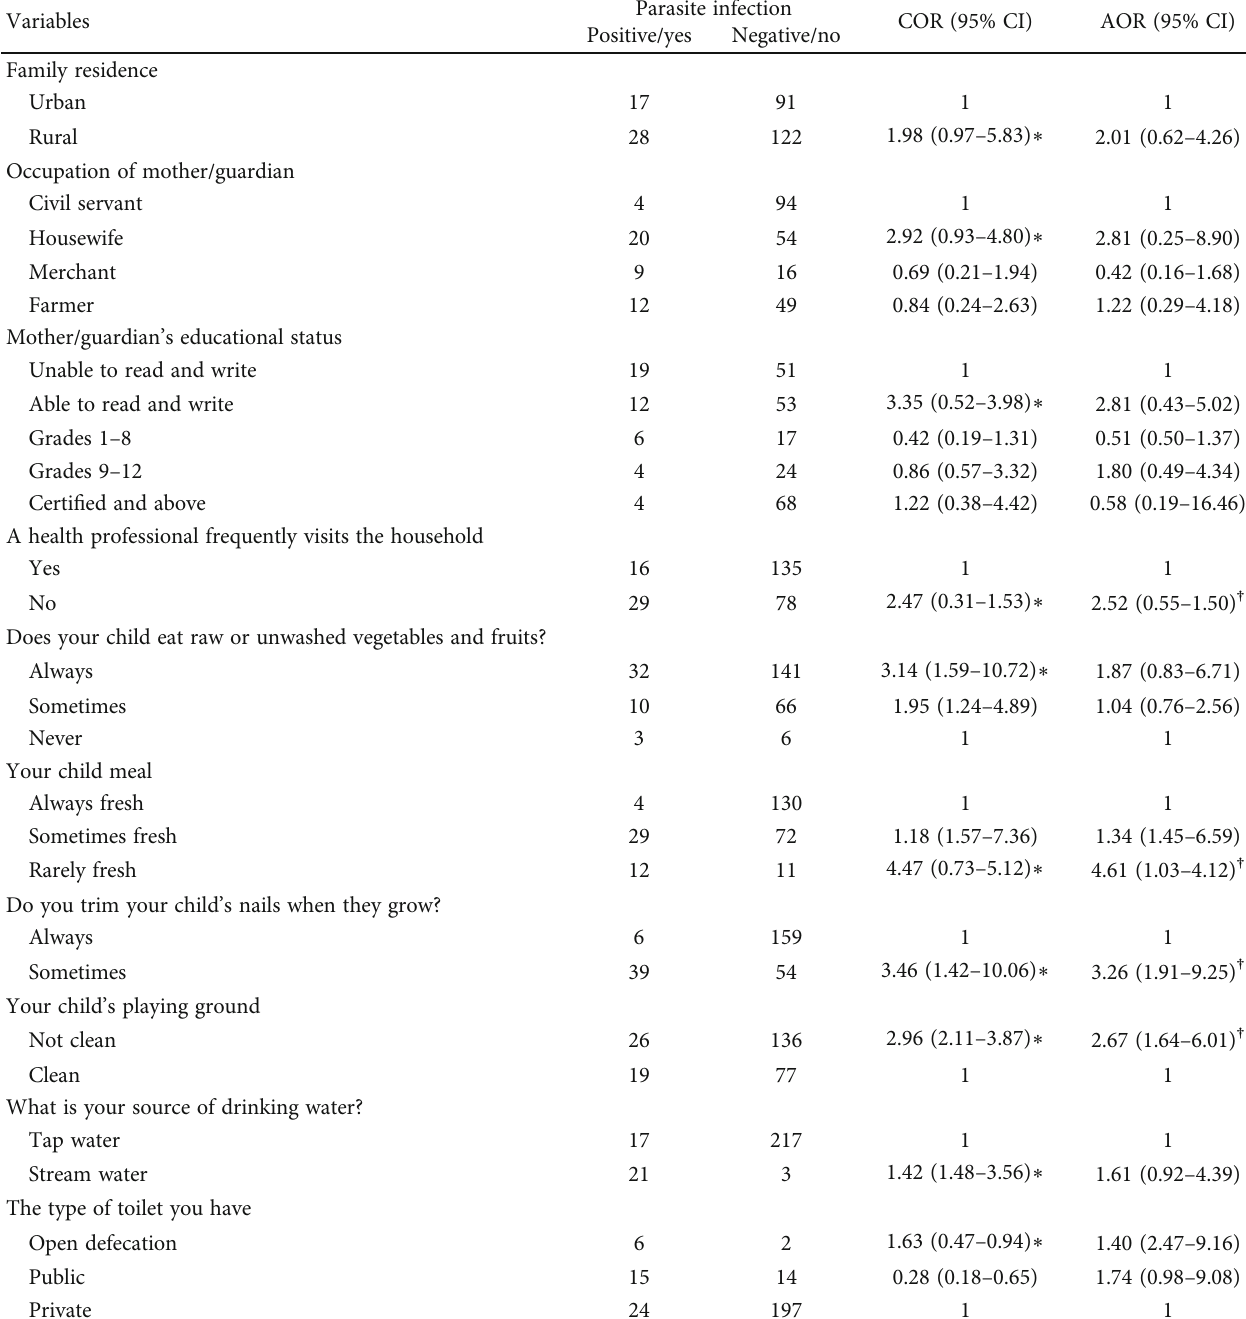
Table 4: Bi-variable and multi-variable logistic regression to determined risk factors for acquiring endoparasites for under- fi ve children attending in Debre Tabor comprehensive specialized hospital, Northwest Ethiopia, 2021 ( n = 258